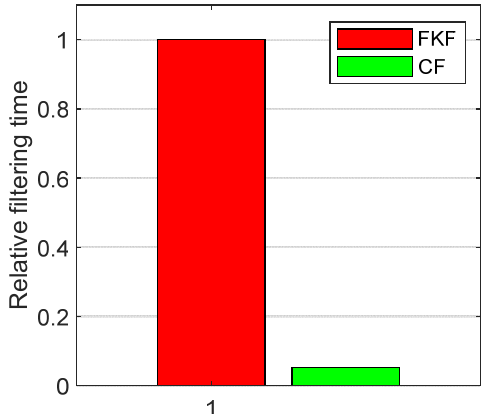
Figure 16. Relative time consumptions of FKF and CF.